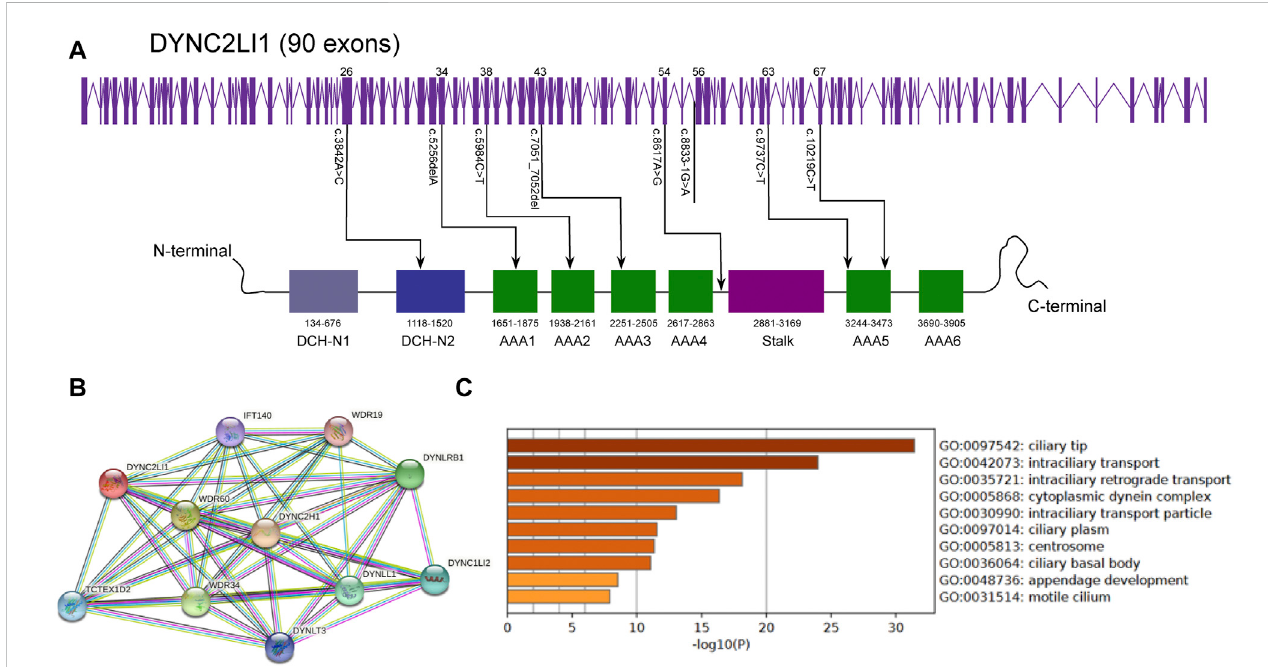
FIGURE 10 DYNC2H1 gene and peptide chain schematics, the protein-protein interaction network and GO terms of genes associated with DYNC2H1 (A) The speci fi c positions of these eight variants in the DYNC2H1 gene and peptide chain schematics. (B) The protein-protein interaction network associated with DYNC2H1 .Circlesareusedtorepresentnodes,andlinesareusedtorepresentedges. (C) GOtermsofthesegenesinprotein-proteininteractionnetwork.The X-axis represents the -log 10(P) and the Y-axis represents the GO